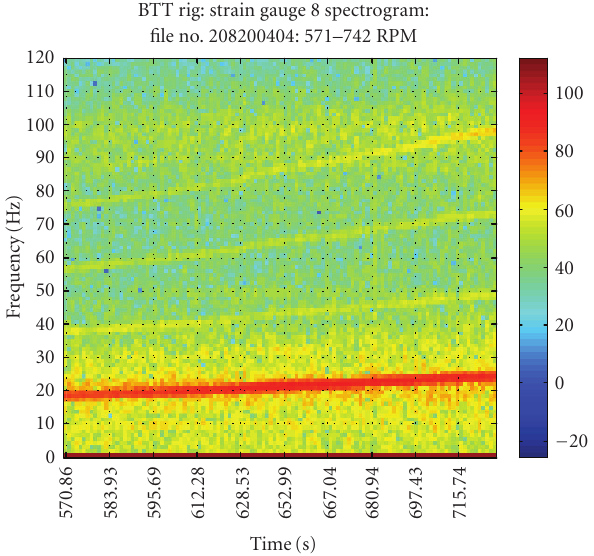
Figure 7: Frequency-speed plot for single resonance case from SG data.